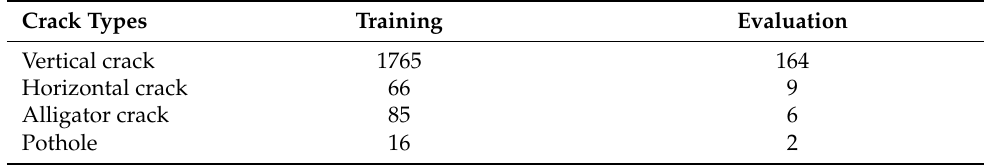
Table 25. Damage occurrences in the Veidekke dataset.